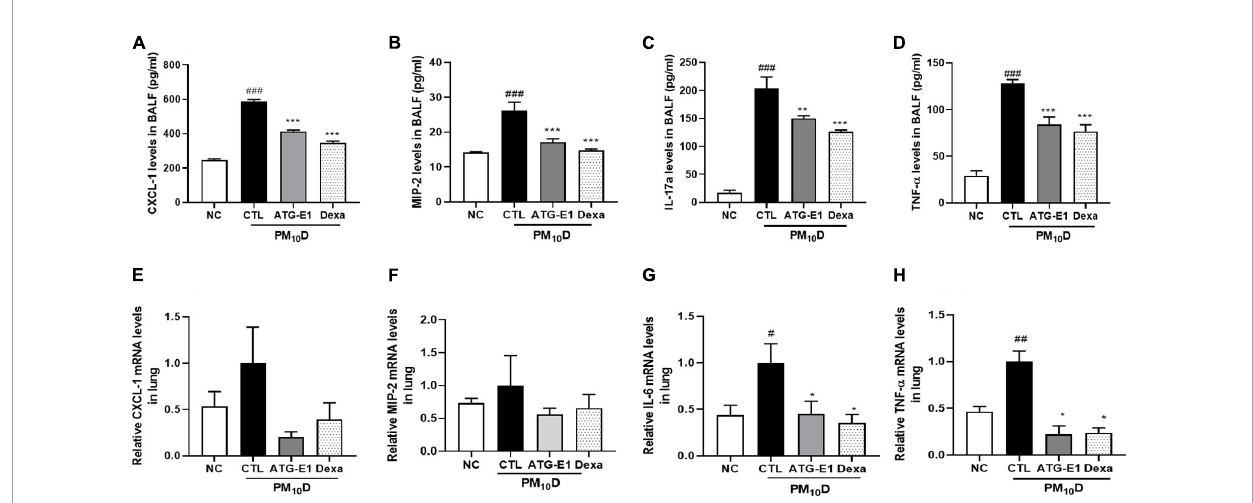
FIGURE4 Effects of L. paracasei ATG-E1 on proinflammatory mediators in BALF and lung of a PM 10 D-induced airway inflammation animal. (A) CXCL-1, (B) MIP-2, (C) IL-17a, and (D) TNF- α levels in the BALF. (E) CXCL-1, (F) MIP-2, (G) IL-6, and (H) TNF- α gene expression levels in the lung. The data are presented as means ± SEM ( n = 8). # p < 0.05, ## p < 0.01, and ### p < 0.005 vs. NC; * p < 0.05, ** p < 0.01 and *** p < 0.005 vs. CTL. NC: normal mice; CTL: PM 10 D-sensitized control mice; Dexa: 3 mg/kg dexamethasone-treated PM 10 D-sensitized mice; ATG-E1: 4 × 10 9 CFU/day of L. paracasei ATG-E1-treated PM 10 D-sensitized